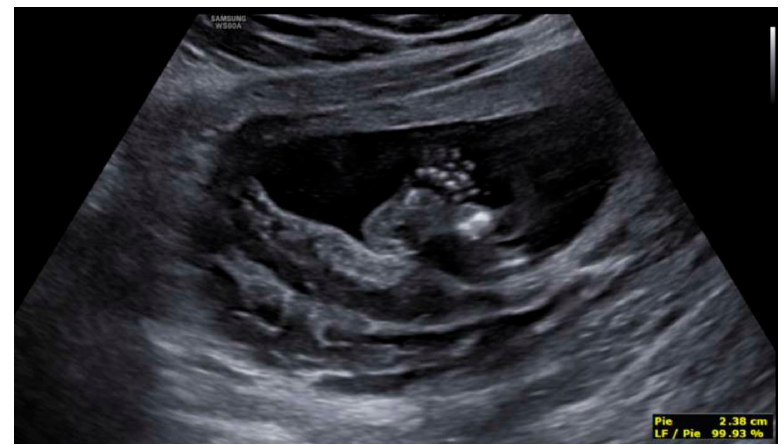
Figure 10. Feet located in forced hyperflexion and with reduced mobility.